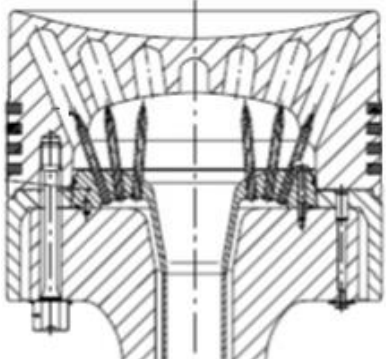
Fig. 9. Example of piston cooling drills in the Sulzer IC engine (repro- duced from Pounder's Marine Diesel Engines [35] with permission from